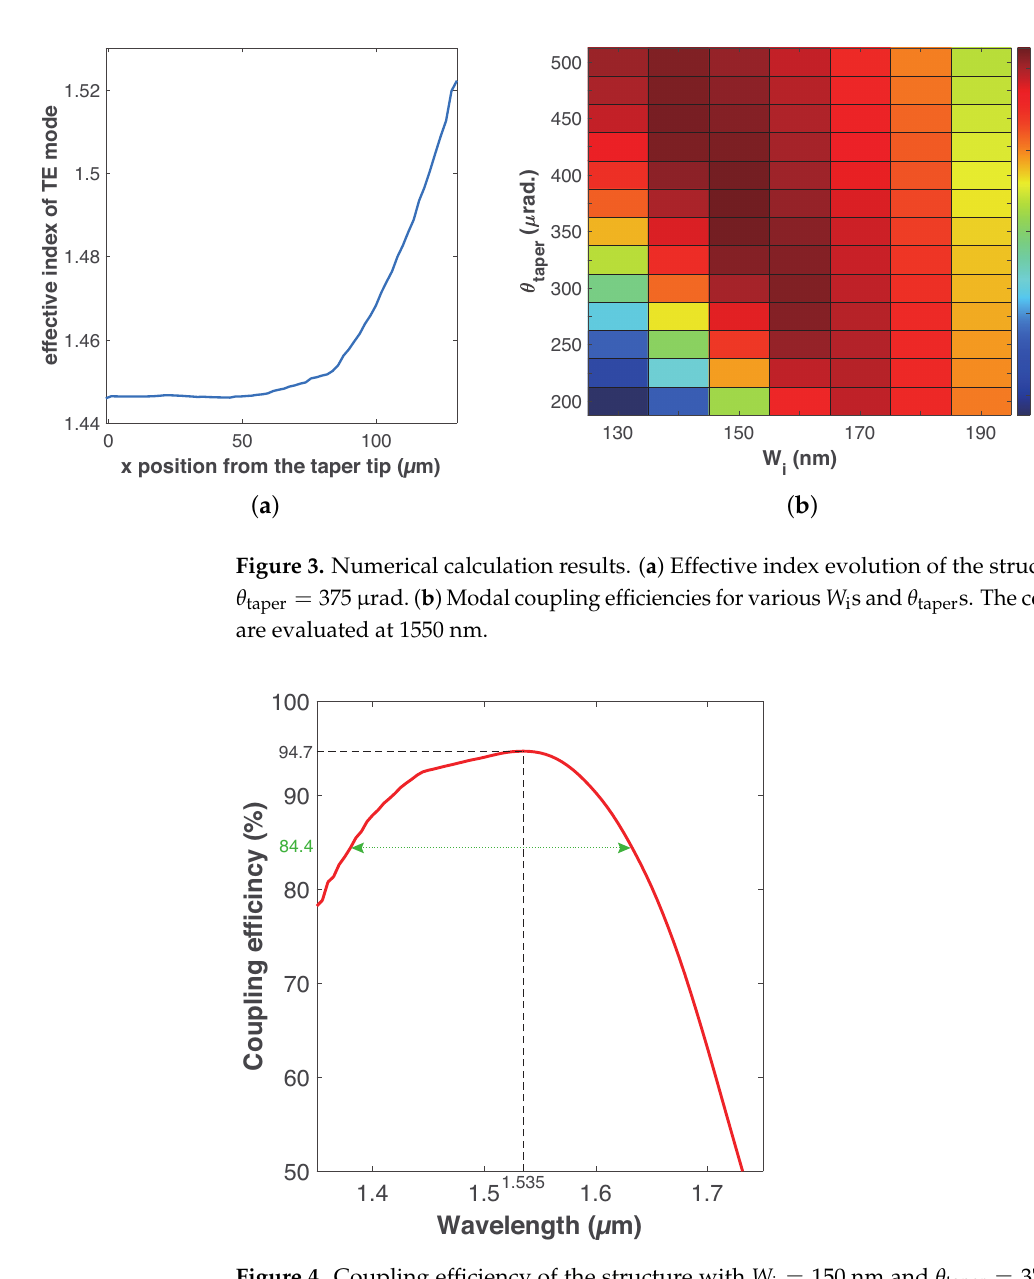
Figure 4. Coupling efficiency of the structure with W i = 150 nm and θ taper = 375 µ rad. The black dashed lines indicate the maximum coupling efficiency and its wavelength; the green dotted line represents when the coupling efficiency drops by 0.5 dB from its maximum value